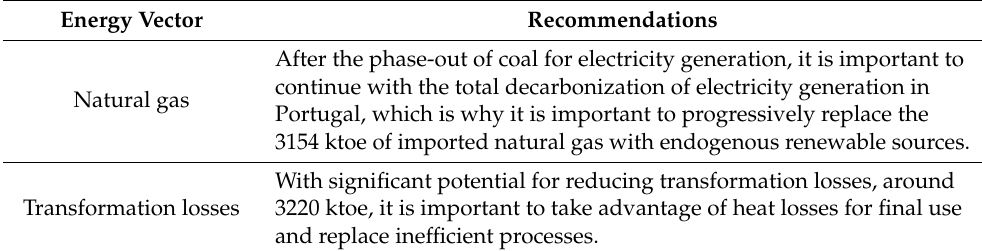
Table 3. Status of the energy vectors available from all sources.